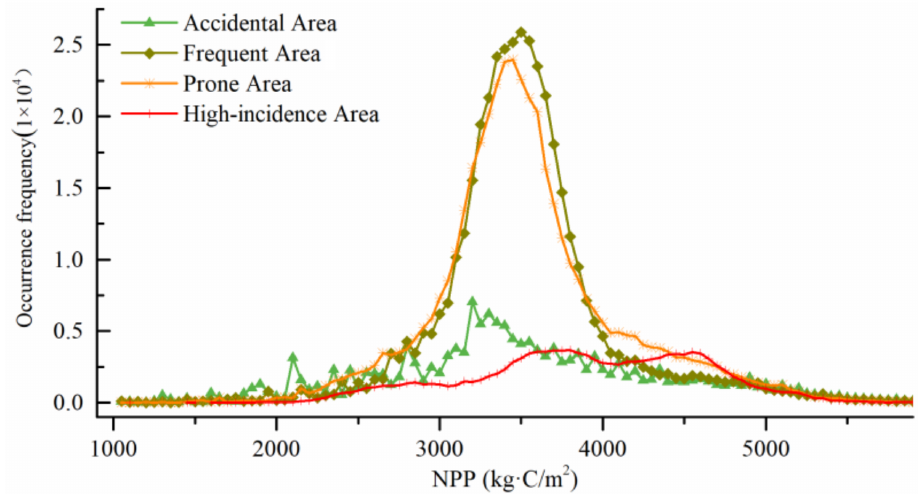
Figure 8. Characteristics of NPP in the four fire-hazardous area of active fires in Northeast China.